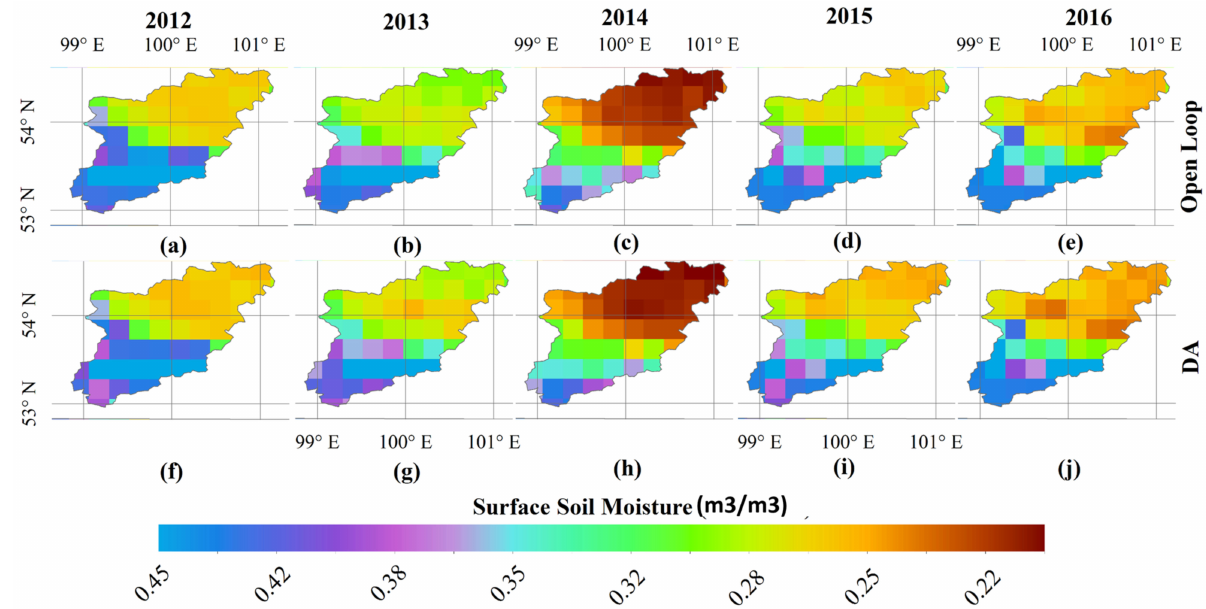
Figure 5. Represents spatial pattern of SM over the Iya Basin during the spring season. Annual mean from open loop are shown in top row ( a – e ), from DA in bottom row ( f – j ).